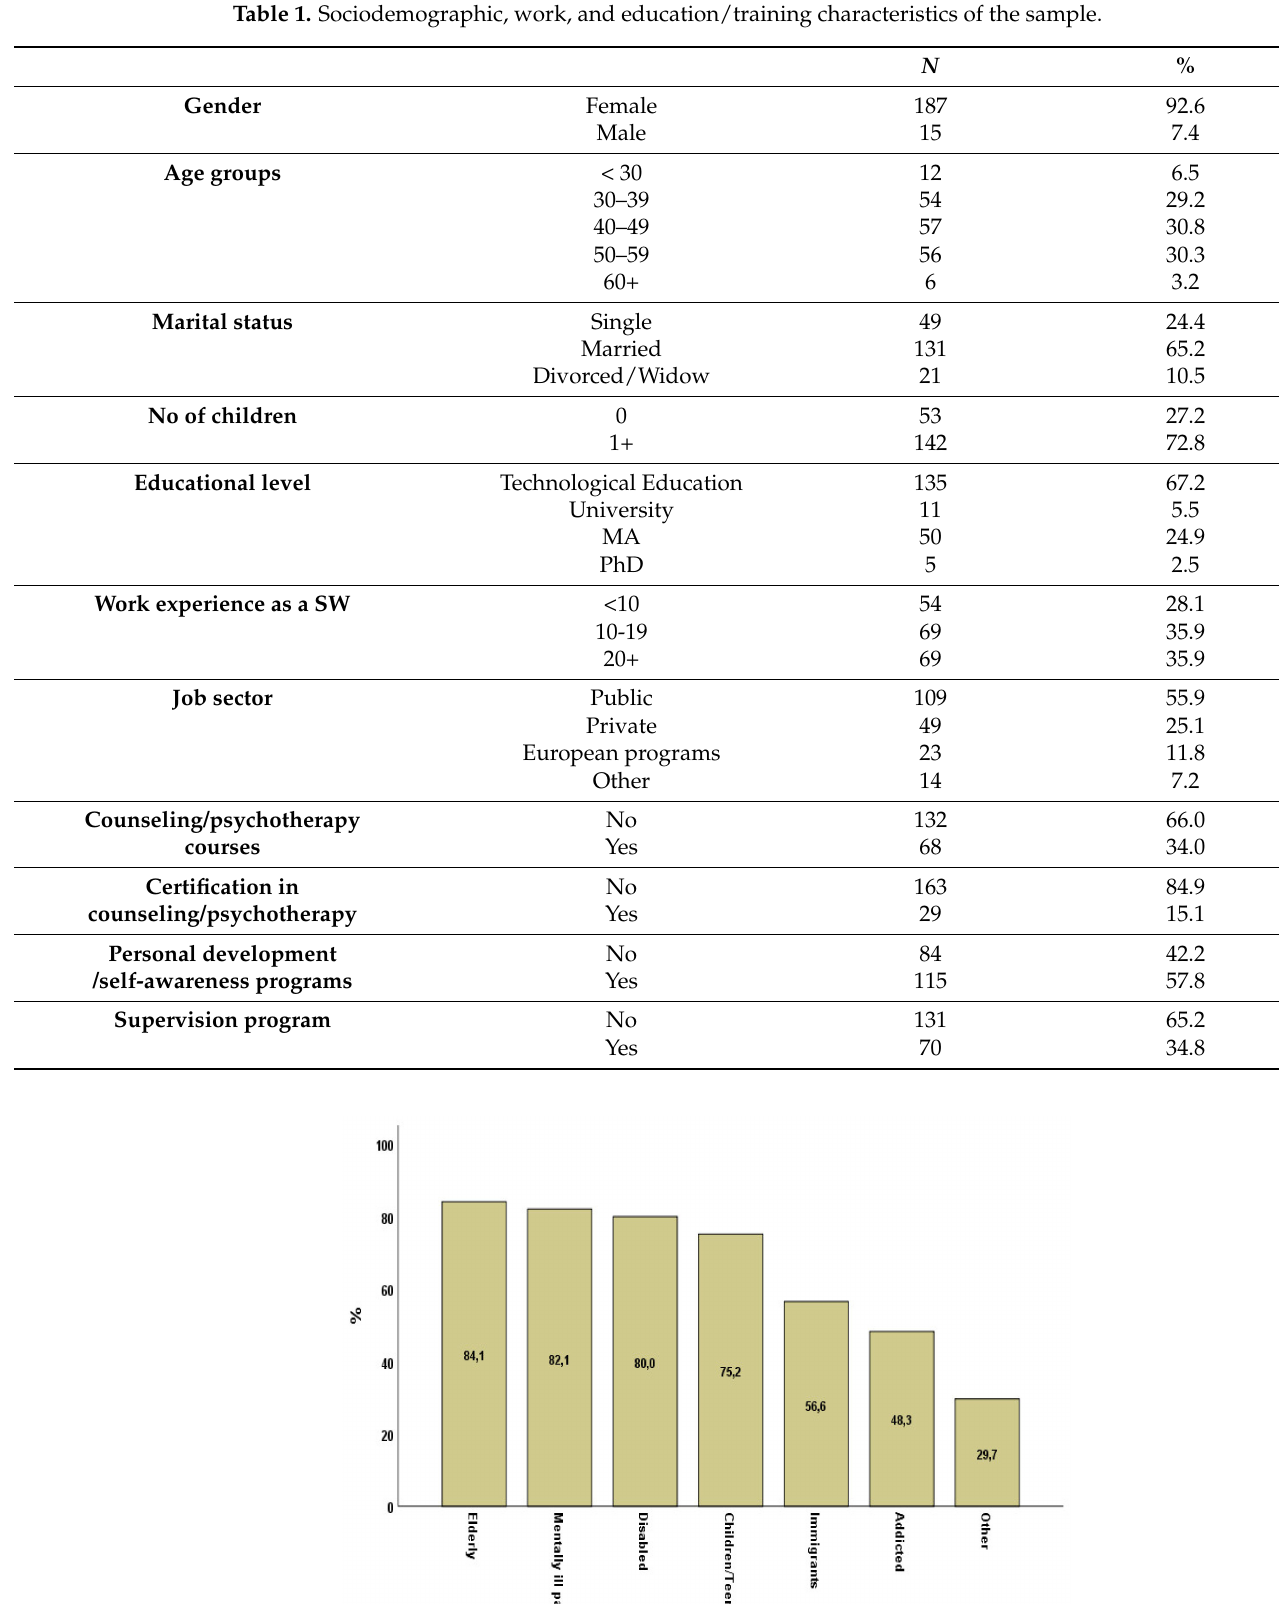
Table 1. Sociodemographic, work, and education/training characteristics of the sample.